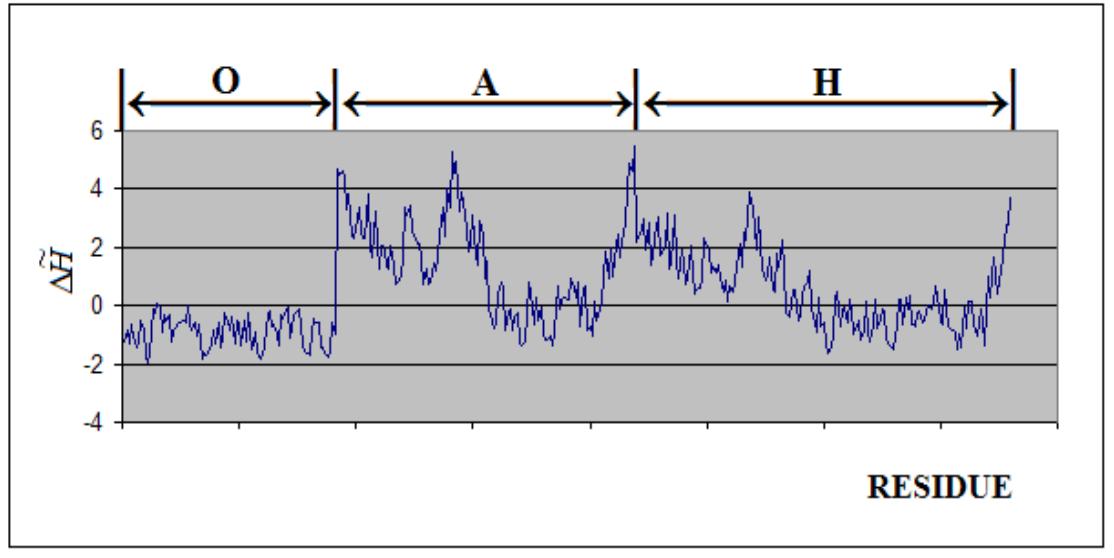
~ Figure 7. The H Δ profile of residues exposed on the internal surface ordered along the X-axis (7-fold symmetry). The Gro-ES (chains O – T) followed by the Gro-EL part: cis- ring generated by the chains A-G and the trans- ring created by the chains H-N.